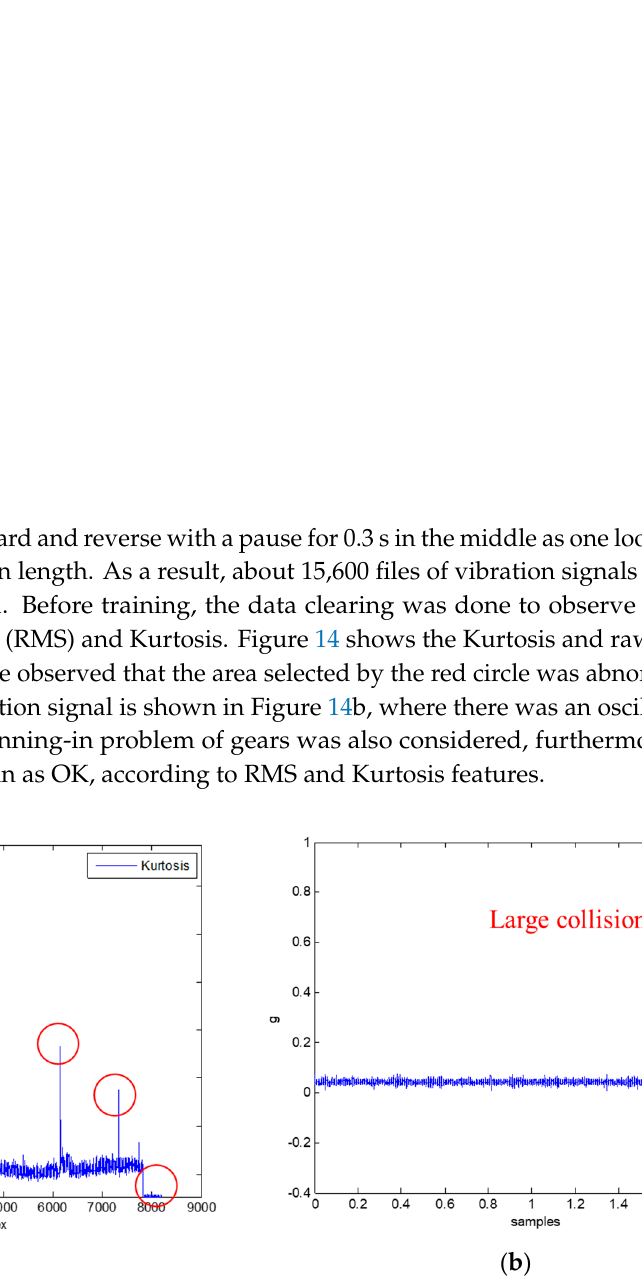
Table 5. The training algorithm and parameters.